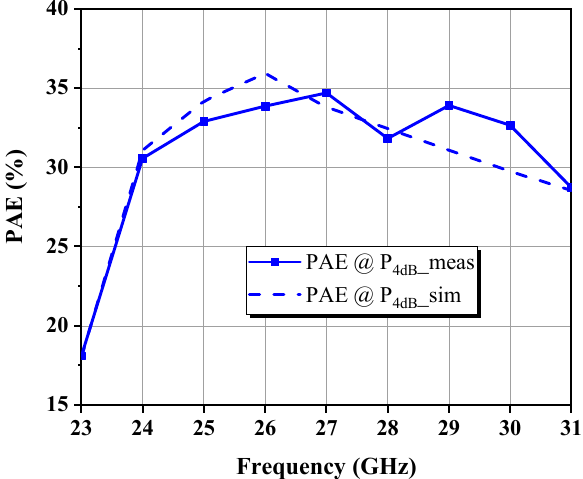
Figure 19. Measured and simulated PAE at P 4dB versus frequency.